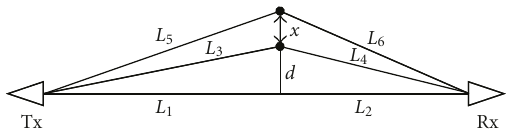
Figure 6: Path length di ff erence. L 1 + L 2 is the path length of the LOS component, L 3 + L 4 is the path length of the multipath component at rest, L 5 + L 6 is the path length of the multipath component when displaced, x is the displacement, d is the distance from the LOS path to the position of a tree component. Tx and Rx are the transmitting and receiving antennas.